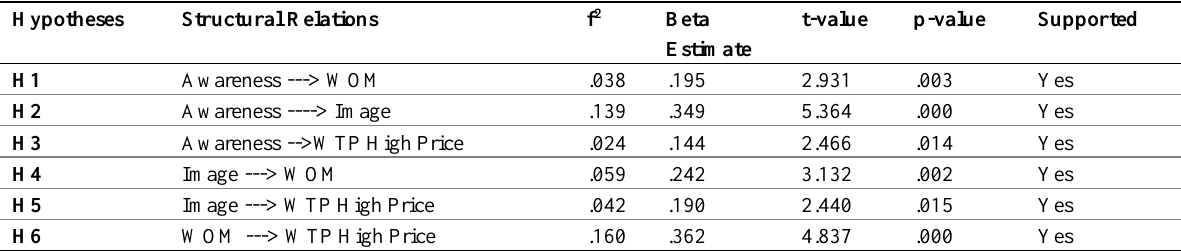
Table 6: Results of Structural